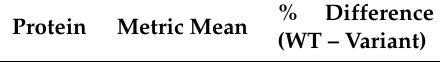
Table 2. Mean RMSD and Rg of the protein plots in Figure 2, and average percentage differences from the WT